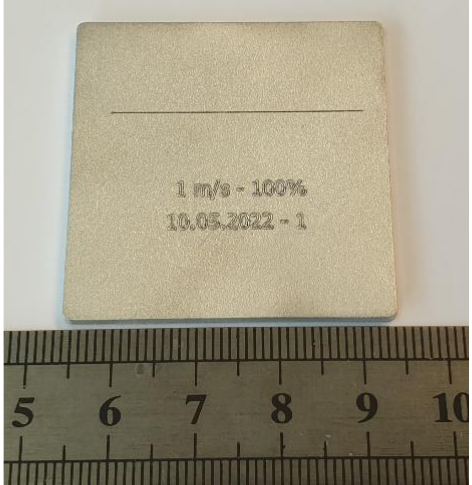
Figure 6. Processed AlMg3 base